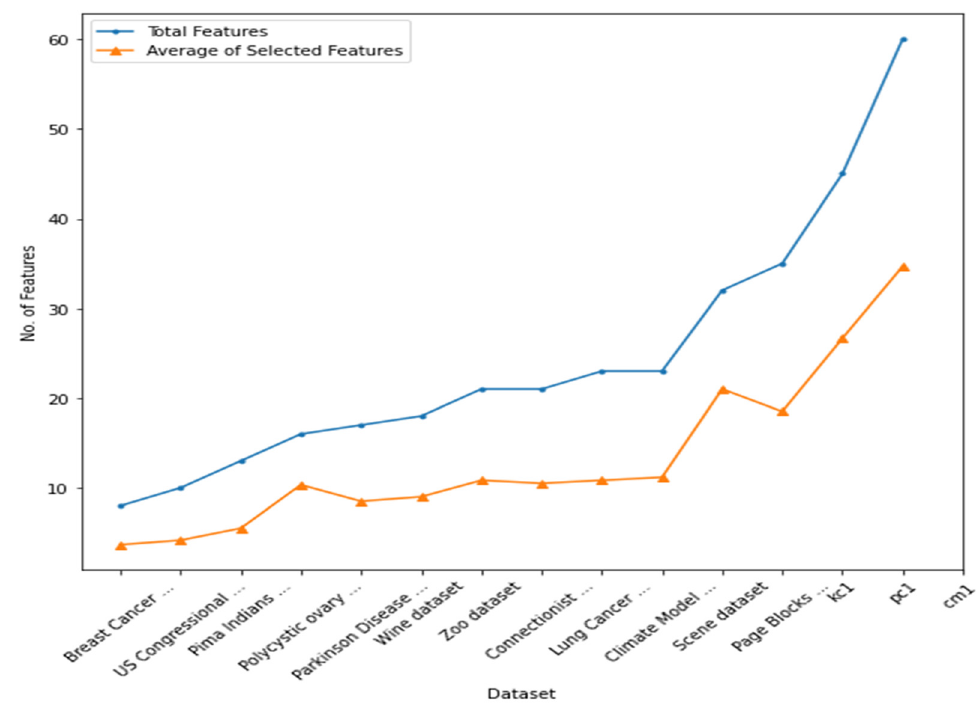
Figure 4. Comparison of total number of features and average number of selected features.